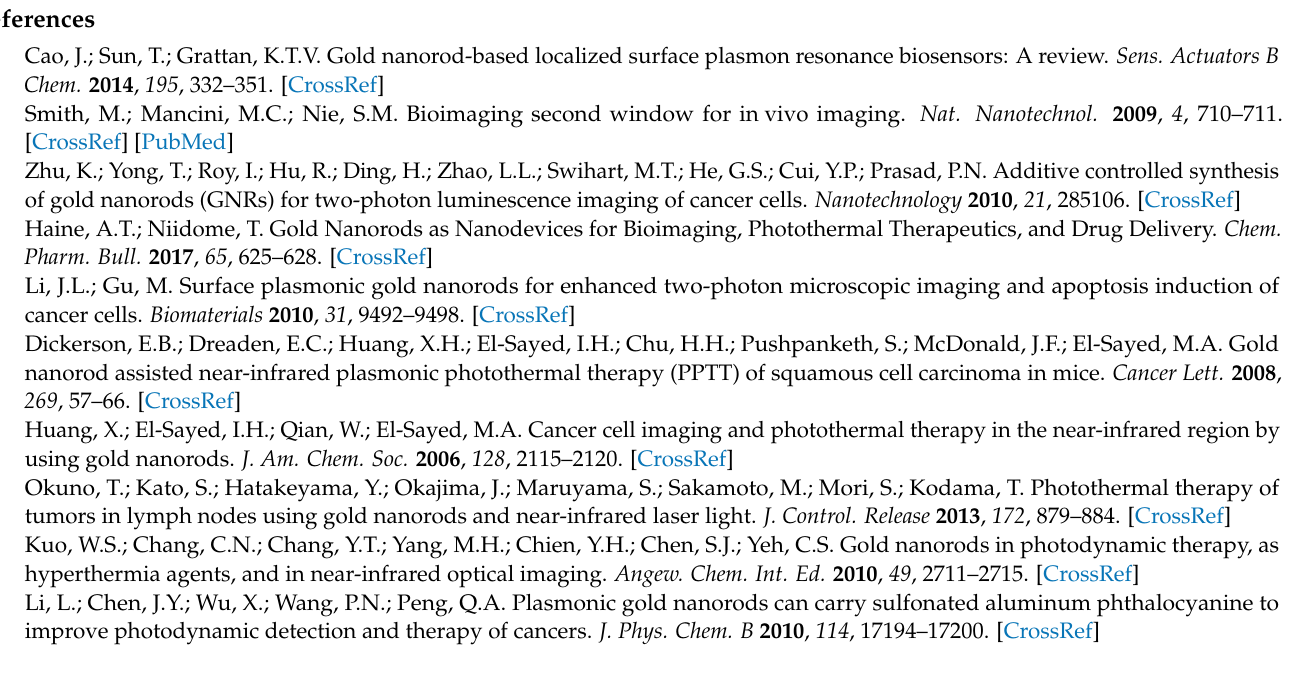
Figure S2. Representative dry-state TEM image of GNRs-Gal-PHEA35, Figure S3. Representative example of UV-Vis absorption spectra for GNRs (blue line), GNRs-Gal-PHEA35 (orange line) and GNRs-Gal-PHEA60 (green line). Inset: zoomed view on the LSPR peak bands, Figure S4. Particle number-based size distribution for GNRs (blue line), GNRs-Gal-PHEA35 (orange line) and GNRs- Gal-PHEA60 (green line) as determined by NTA, Table S1. Characterization of